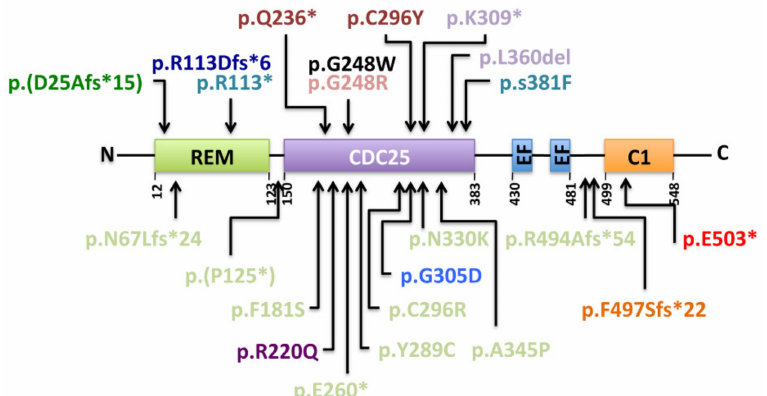
Figure 4. Localization and predicted consequence of the RASGRP2 reported variants in humans. The variant reported by Canault et al. [58] is shown in black. The variants identified by Lozano et al. are highlighted in turquoise, by Kato et al. [96] in light purple, by Sevivas et al. [60] in brown, by Westbury et al. [91] in light green, by Desai et al. [84] and Westbury et al. in orange, by Bermejo et al. [89] and Wesbury et al. in light blue, Lyu et al. [92] in dark green, Yun et al. [90] in purple, Lunghi et al. [93] in dark blue, Manukjan et al. [94] in pink and the newly identified variant id indicated in red. Variants in brackets are prediction of intronic modifications a ff ecting splice regions. Sequences of the variants are annotated according to the consensus nomenclature to describe variant e ff ect at the protein level (fs = frameshift, del = deletion, * = change to a stop codon, variant in brackets represent